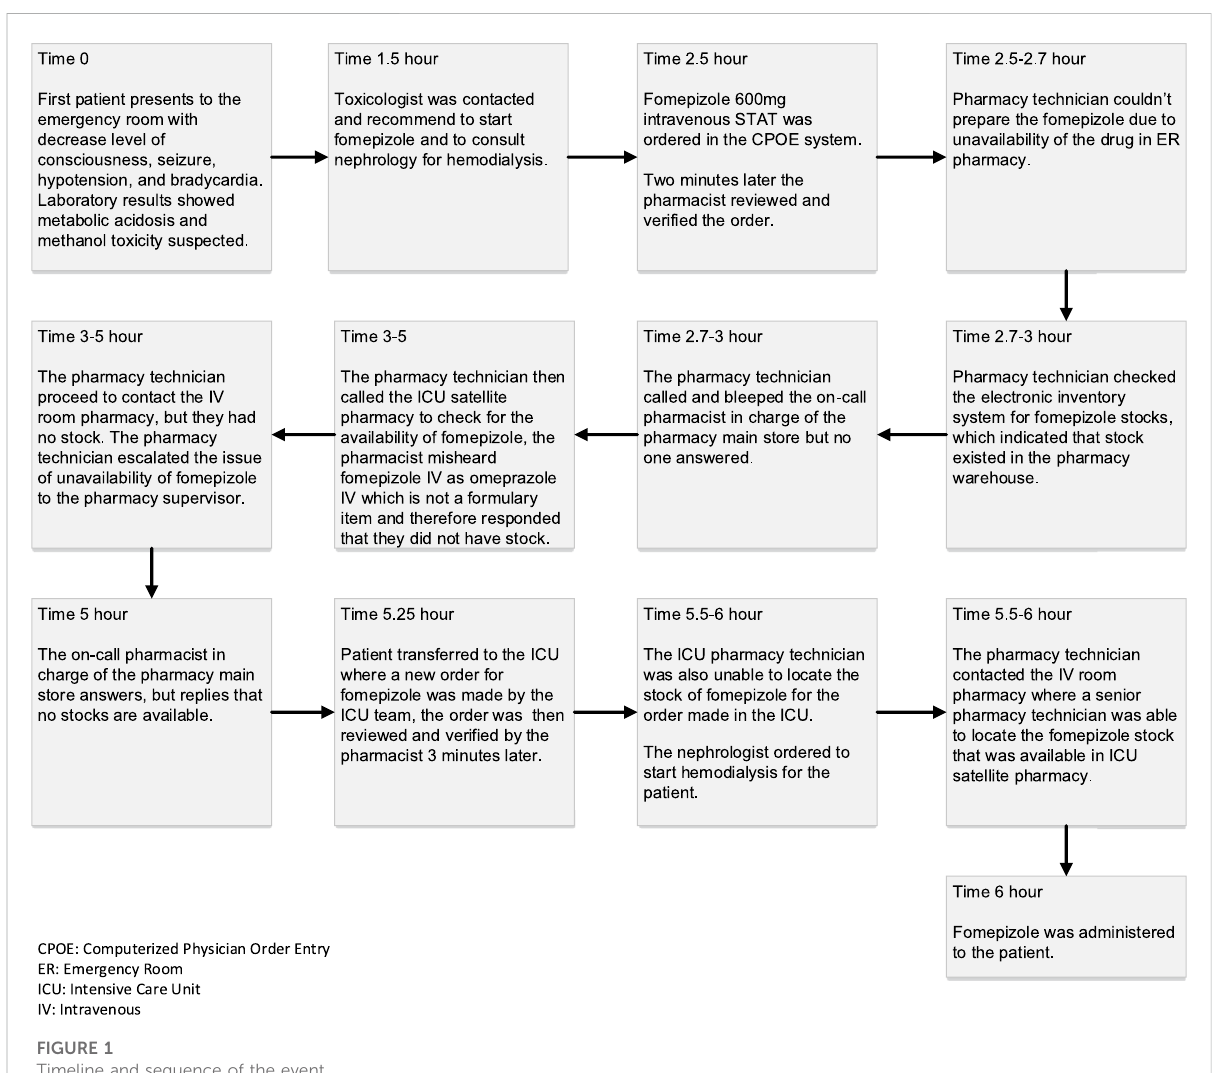
FIGURE 1 Timeline and sequence of the